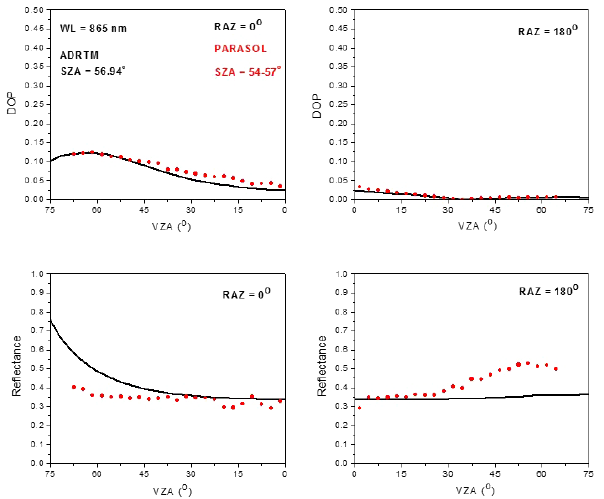
Figure 17. Comparison of the modeled DOP and reflectance of desert-reflected solar light at RAZs of 0 and 180 ◦ with those from the PARASOL data at the wavelength of 865nm. The SZA is 56.94 ◦ in the modeling. The SZA is in the bin of 54–57 ◦ for the PARASOL data.